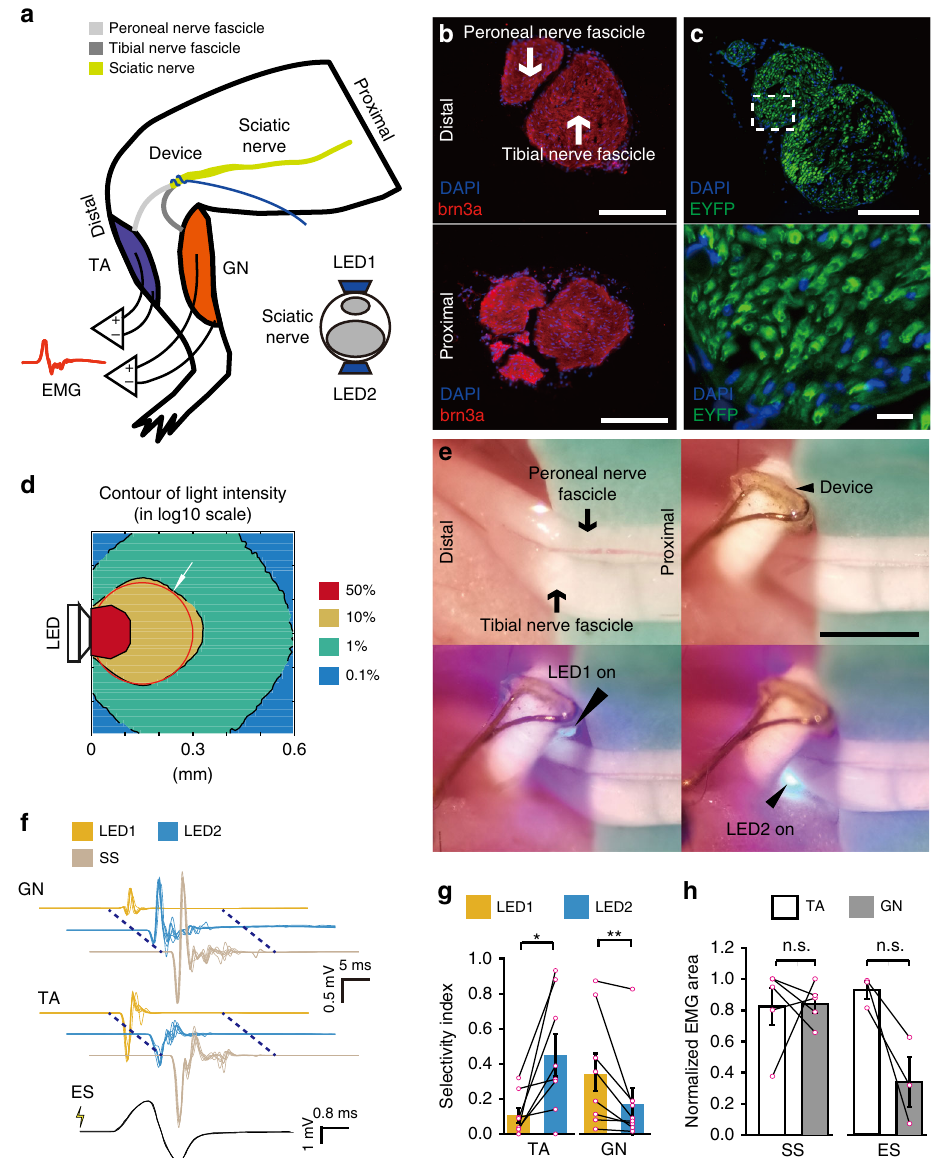
Fig. 3 MOSD stimulation of the sciatic nerve in Thy1 - ChR2 mice. a Schematic diagram of the MOSD attached to the distal side of a sciatic nerve. Stimulation was provided at 0.2 Hz (turned on for 20 msec-on/5 sec-off). Electromyography was performed on the tibialis anterior muscle (TA) and gastrocnemius muscle (GN). b Cross section of the sciatic nerve at the location of the MOSD (upper panel) and 4 mm from the location of the MOSD (lower panel). Red staining is brn3a, and blue staining is DAPI. c Transverse section of the sciatic nerve. Green staining is ChR2-EYFP, and blue staining is DAPI. d Monte- Carlo simulation of mini-LED light intensity across and around the mouse sciatic nerve. The red circle indicates the sciatic nerve in adult mice with a 300- μ m diameter. e Mini-LED1 and 2 of the MOSD positioned on the distal side of the sciatic nerve to stimulate peroneal and tibial nerve fascicles at 0.026 mW (20 msec on-2sec off), respectively. f Representative electromyogram recorded from the TA and GN by different mini-LEDs of MOSD (20. 4 mW power, calculated light intensity at the distal end was 134.8 mWmm − 2 , 20 msec-on/2 sec-off), single-site optogenetic stimulation (81.6 mW power, calculated light intensity at the distal end was 539.2 mW mm − 2 , 20 msec-on/2 sec-off) and electrical stimulation in mice. The electrical stimulation pulse was 0.6 mA for 0.2 msec. g , h Normalized myoelectric area of the TA and GN in response to different mini-LED stimulations ( n = 8 mice, 1.31 mW – 20.4 mW, 20 msec-on/2 sec-off, TA: Paired t- test, GN: Wilcoxon Signed Rank Test), single-site optogenetic stimulation ( n = 5 mice, paired t test) and electrical stimulation ( n = 3 mice, 4.55 mW, 20 msec-on/2 sec-off, Paired t- test). SS: Single-site optogenetic stimulation; ES: electrical stimulation. Data are presented as mean ± s.e.m.; * P < 0.05, ** P < 0.01. Scale bars are 100 µ m ( b , c (top)), 10 µ m ( c (bottom)) and 200 µ m ( e